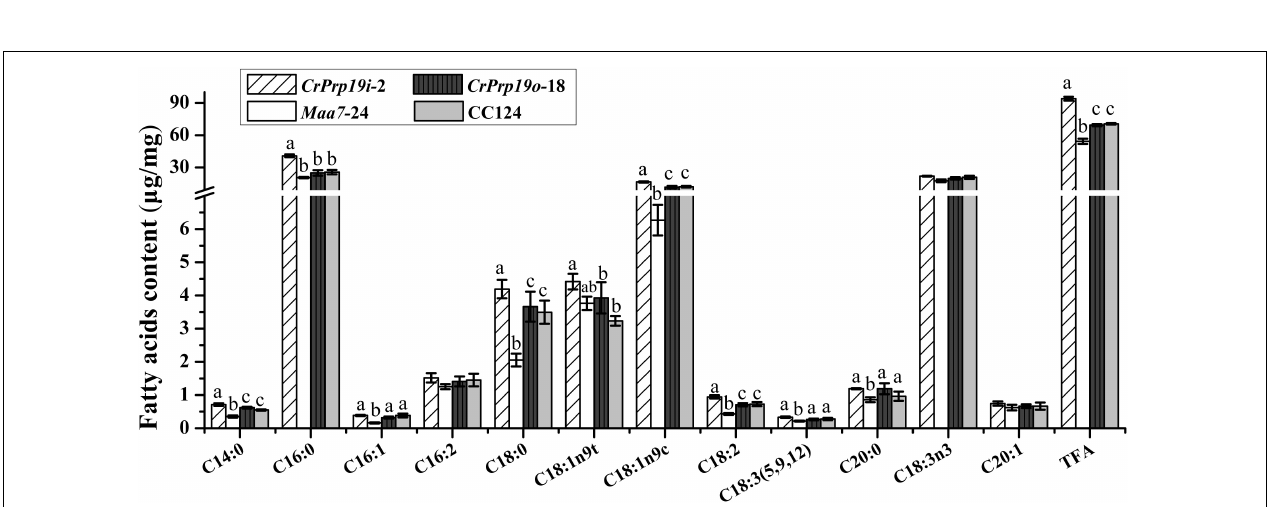
FIGURE 5 | Cells and accumulated lipid droplets in CrPrp19 RNAi and overexpression lines. Cells cultured for 7 days were stained by Nile Red staining and photographed by fluorescence microscopy. Scale bar, 10 µ M. 1st row: Bright field, 2nd row: fluorescence microscopy images stained with Nile Red, red showed chlorophyll autofluorescence, yellow showed lipid drops. 3rd row: Cells after synchronization culture for 4 days.